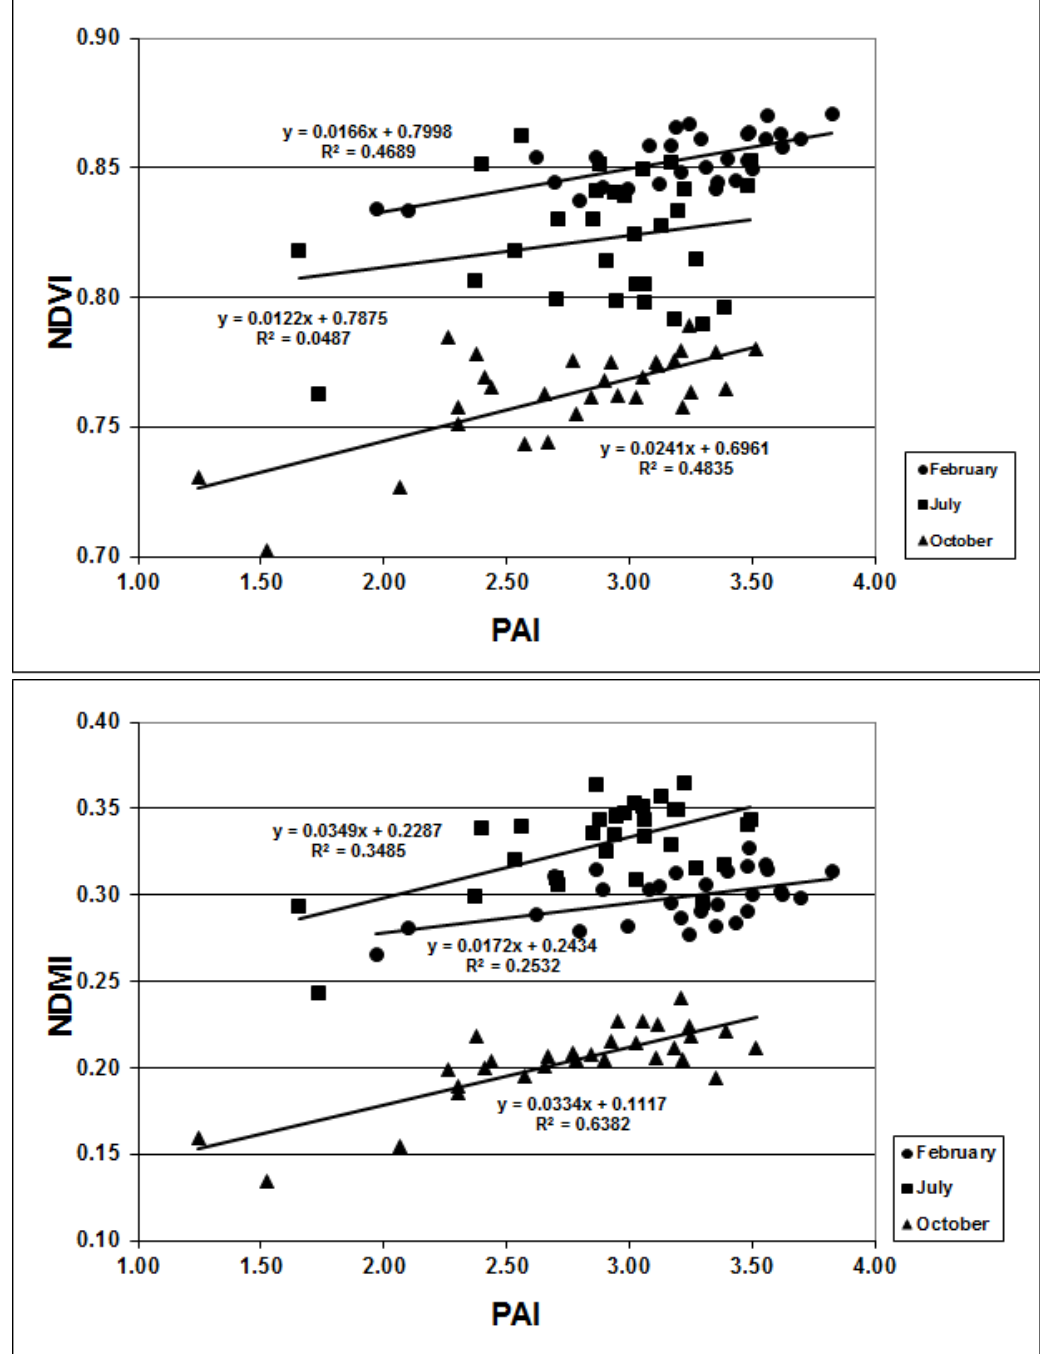
Figure 4. Linear regression models built with PAI, NDVI and NDMI from each sample point and at each field